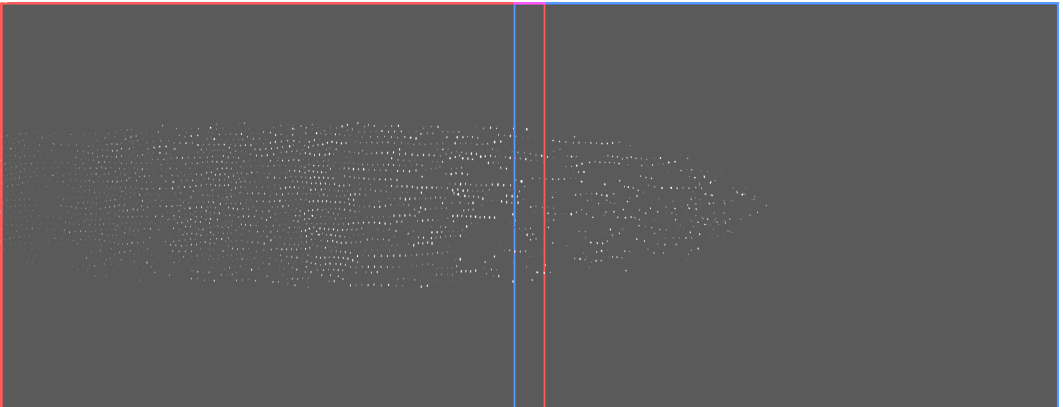
Figure 2. Combined contrast and brightness enhanced images of the two PO cameras. The red frame marks the field of view of Camera 1, the blue one that of Camera 2 (each has a size of 1600 × 1200px 2 ). The pixels in the top right side where no data were recorded were set to black. Combined FoV: 44.1 × 17.1mm 2